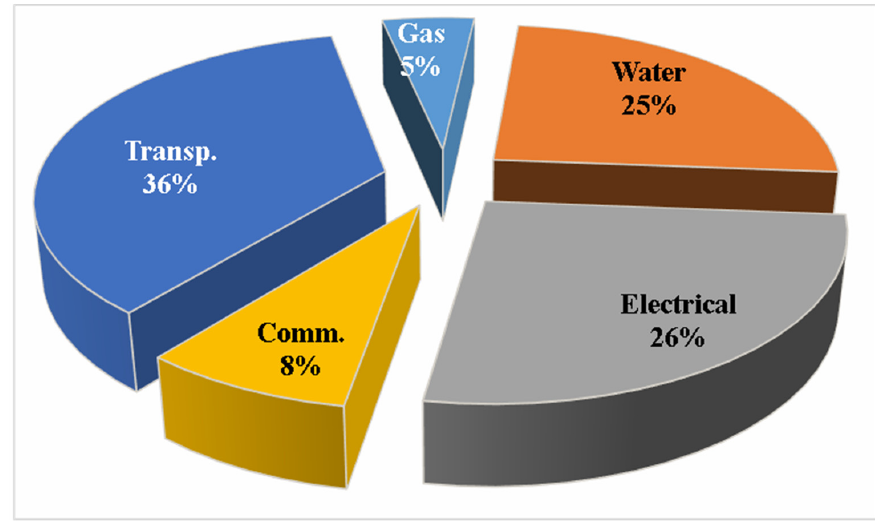
Figure 15. Implementing AI techniques in each considered infrastructure subject.